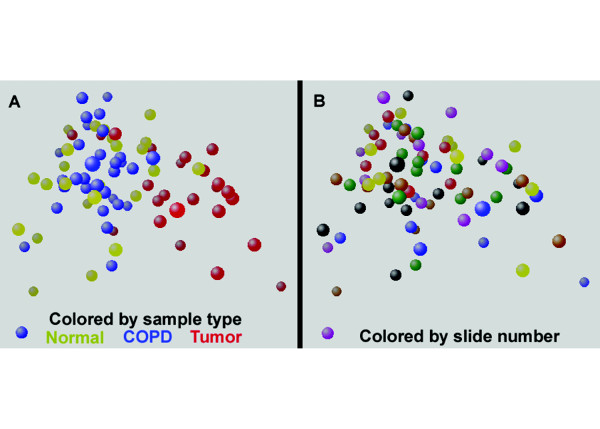
The first 3 principal components from normalized log-base-2 ratios of sample to reference pool intensities, using all 84 antibodies. The full 3-dimensional figures that can be rotated are available in the supplementary materials. In A, normal, COPD and lung cancer patients are marked with yellow, blue and red, respectively. The first three principal components account for 43% of the variance. In B, seven slides are marked separately with blue, black, yellow, green, purple, brown and red.